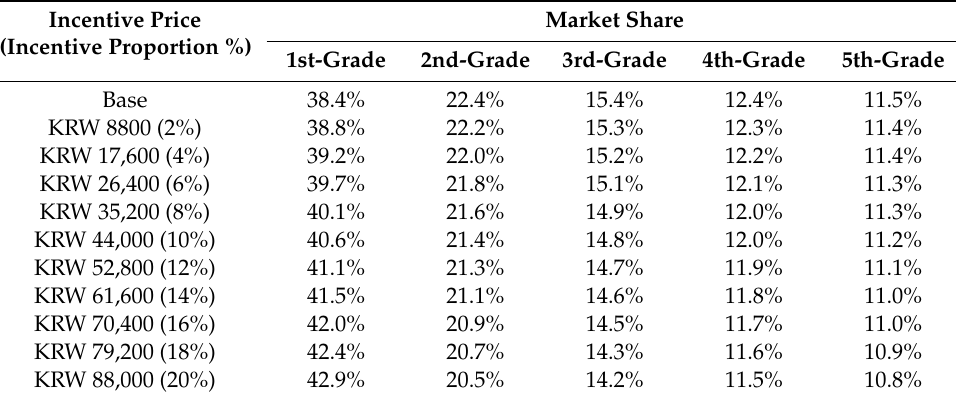
Table 7. Change in market share by incentive